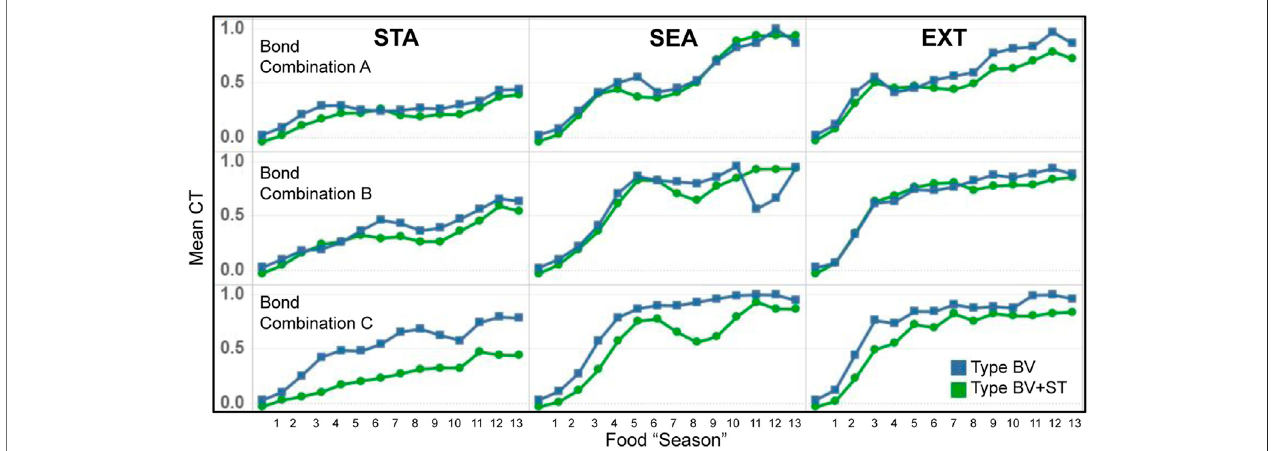
FIGURE 9 | Temporal evolution of mean CT levels for bonded agents in Type BV (blue) and Type BV+ST (green) model conditions, across the different environmental conditions. STA = Static, SEA = Seasonal, EXT = Extreme world conditions, respectively.